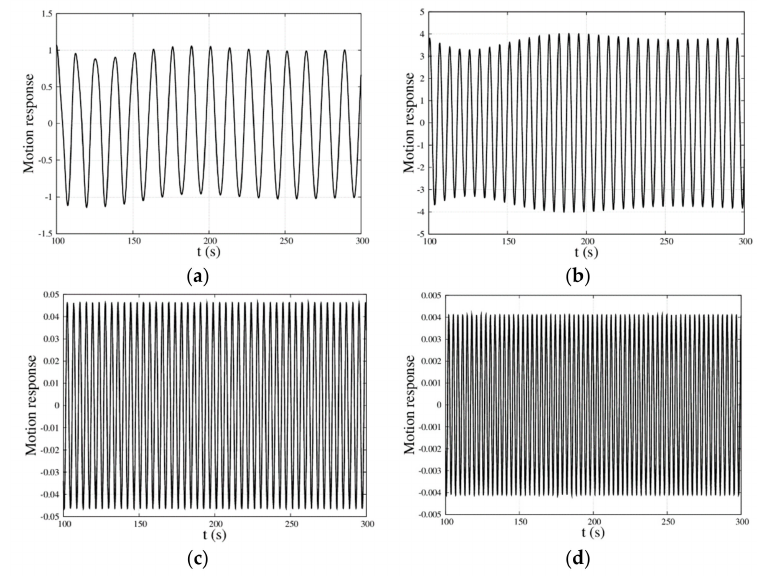
Figure 12. Motion response with time for the MP–WEB with di ff erent frequency; ω = 0.5, 1.0, 1.5, and 2.0 ( rad/s ) . ( a ) ω = 0.5 ( rad/s ) ; ( b ) ω = 1.0 ( rad/s ) ; ( c ) ω = 1.5 ( rad/s ) ; and ( d ) ω = 2.0 ( rad/s ) .